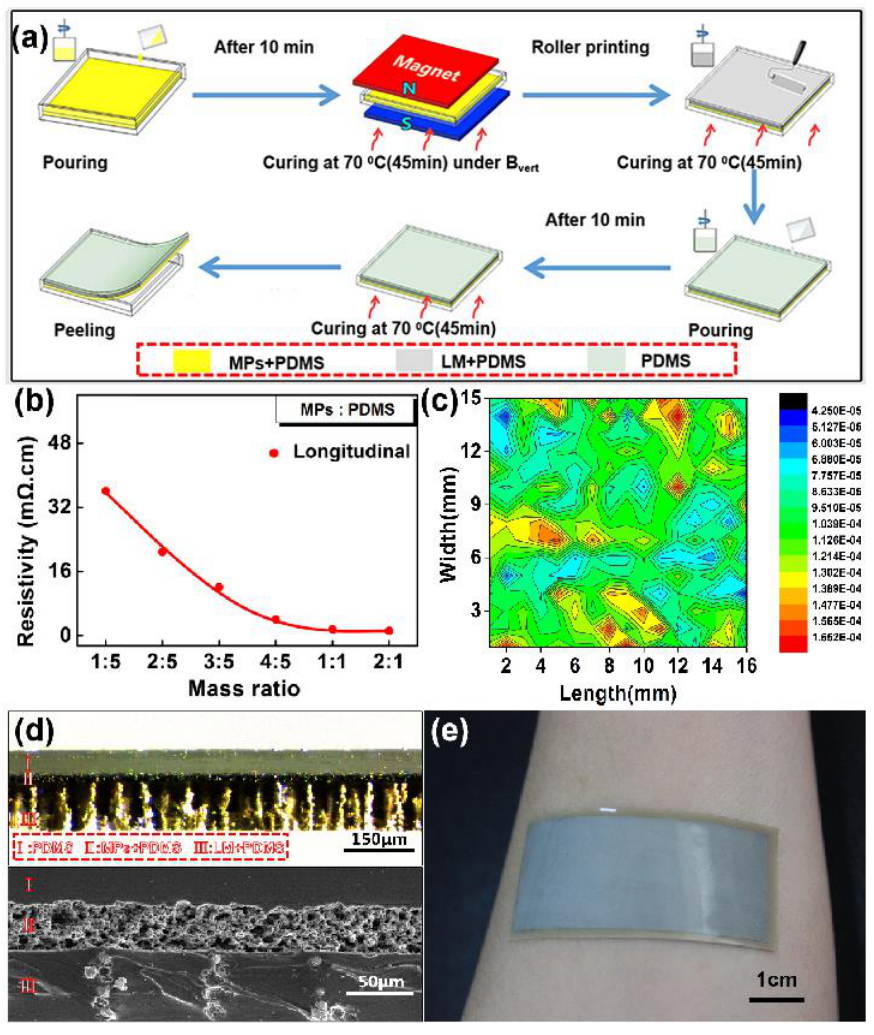
Figure 2. Fabrication of three-layered elastic sEMG electrode: ( a ) Schematic illustration for the fabrication of elastic sEMG electrode. ( b ) Change in longitudinal resistivity of bottom layer (MPs + PDMS) under di ff erent mass ratios. ( c ) The mapping images of surface resistivity of elastic electrode. ( d ) The cross-sectional images of electrode: optical microscope image (top) and scanning electron microscope (SEM) image (bottom). ( e ) A photograph of the electrode sample conformed to skin.